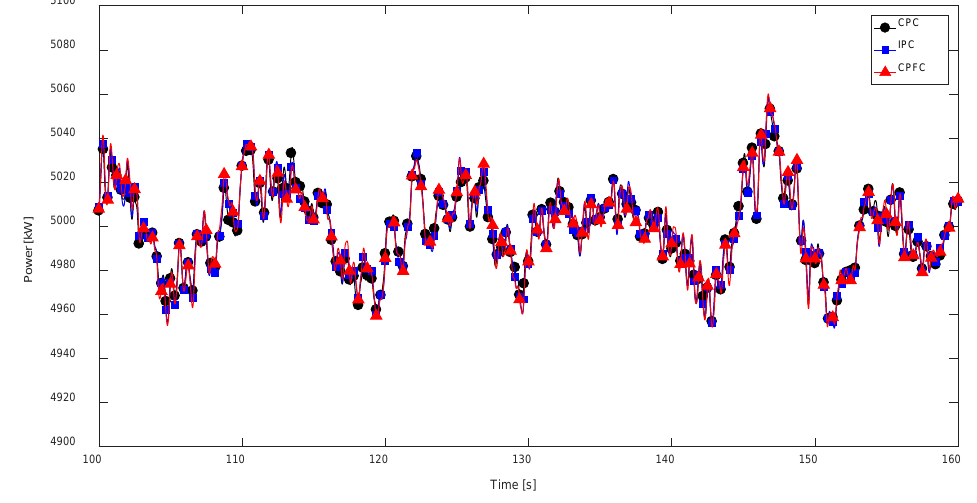
Figure 10. The power generation of a wind turbine.